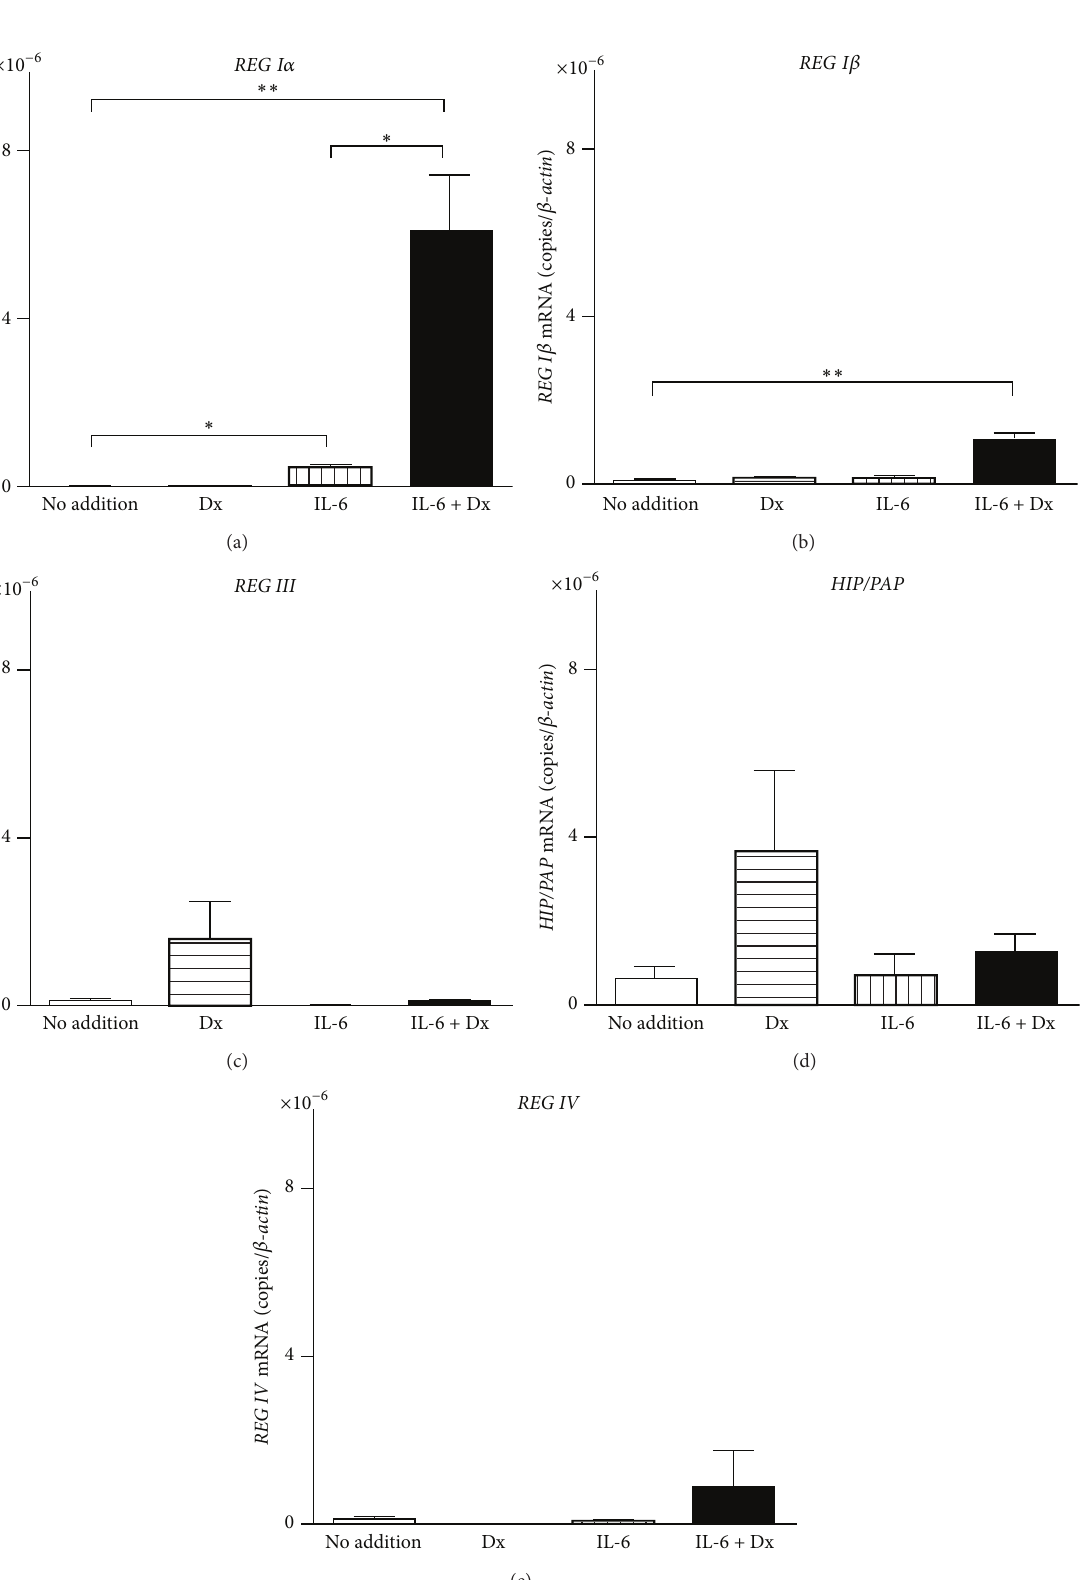
Figure 3: The mRNA levels of (a) REG I 𝛼 , (b) REG I 𝛽 , (c) REG III , (d) HIP/PAP , and (e) REG IV in human 1.1B4 cells treated without (no addition) or with Dx (100nM), or IL-6 (20 ng/mL), or IL-6 + Dx. Data are represented as the ratio of the number of target mRNA copies to the number of 𝛽 -actin mRNA copies and expressed as means ± SE for each group ( 𝑁 = 4 ). ∗ 𝑃 < 0.05 ; ∗∗ 𝑃 < 0.005